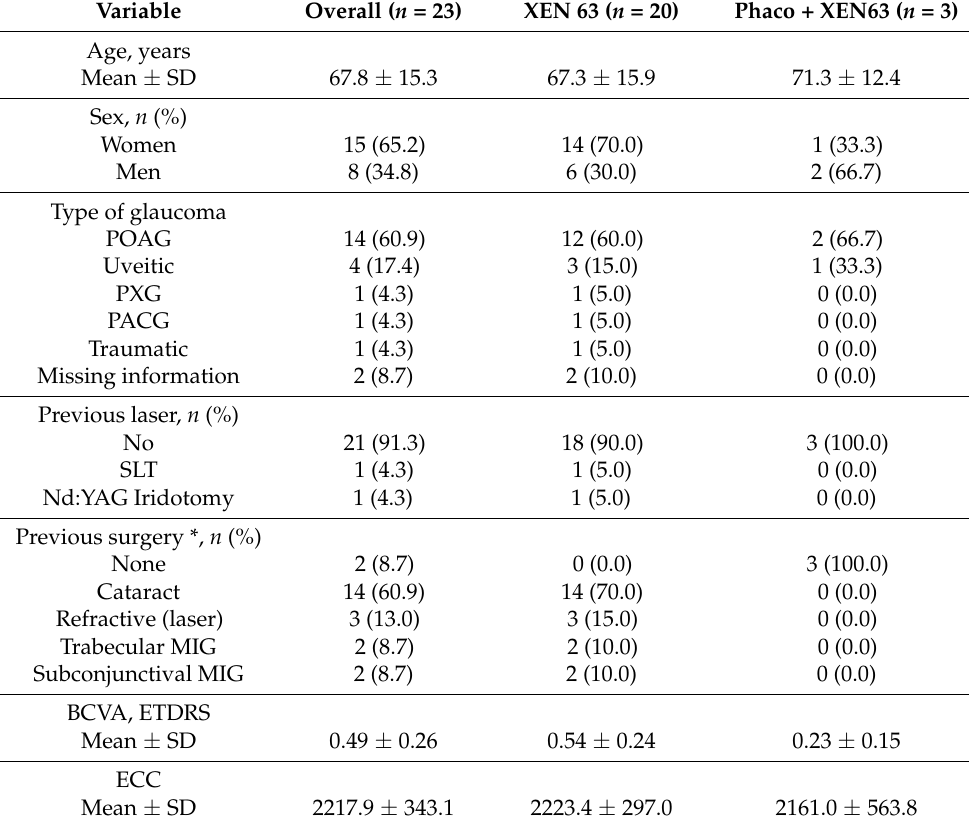
Table 1. Main baseline clinical and demographic characteristics of the study sample.